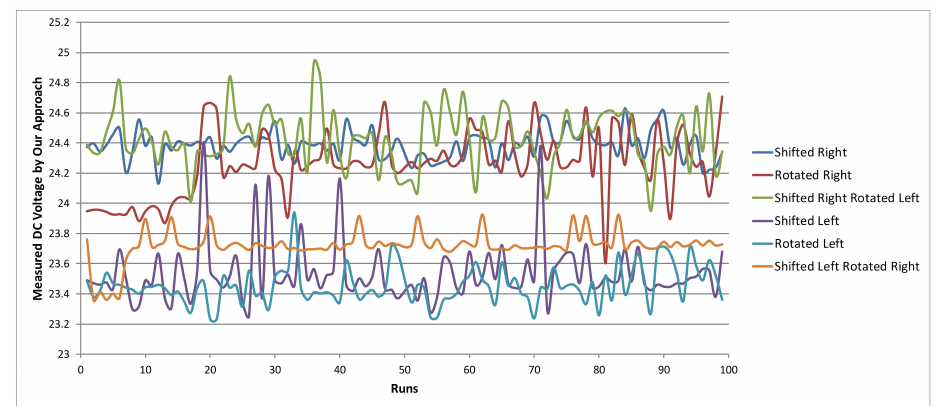
Figure 19. Plots of the measured DC voltages by our computer vision-based approach for reading the A-meter with different translations and/or rotations. The ground truth was 24 Vdc (the DC voltage), as provided by a tester calibrator (model AOIP CMU